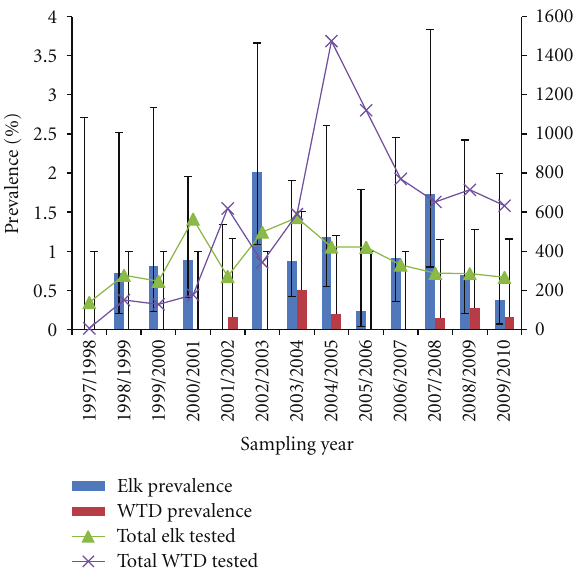
Figure 2: Overall estimated annual prevalence of M. bovis and total number of elk and white-tailed deer sampled from south-western Manitoba from 1997 to